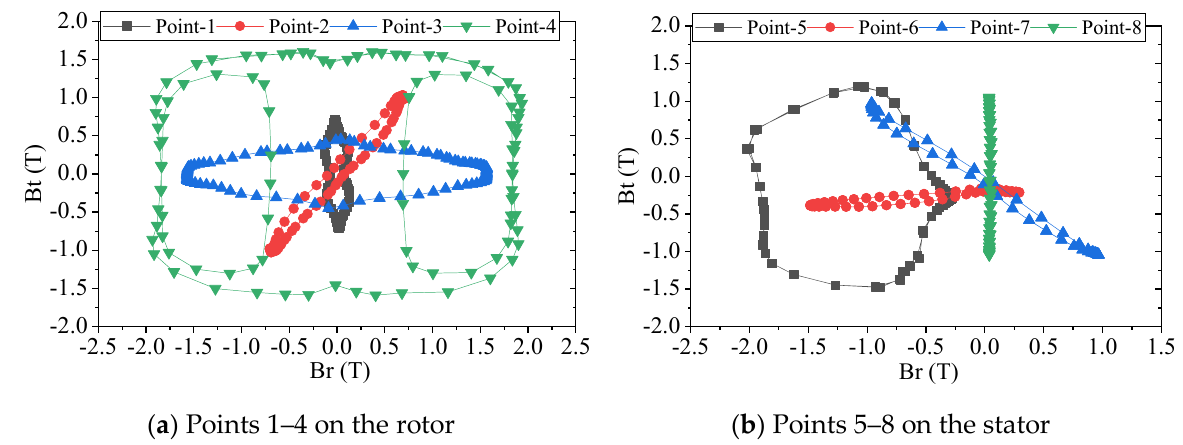
( a ) Points 1–4 on the rotor ( b ) Points 5–8 on the stator Figure 3. Flux density vector trajectories of the key eight points in the rotor and stator cores. Based on the results above, for the stator core, the period of flux density changes is T s = 60/(n × P r ), where n is the rotor speed (rpm) and P r is the number of rotor pole pairs (being the same as the rotor tooth number), and the mechanical angle corresponding to one electrical cycle is 360 ◦ /P r = 36 ◦ . For the rotor core, it should be rotated through at least two stator teeth before its radial and tangential flux density coincides with its initial